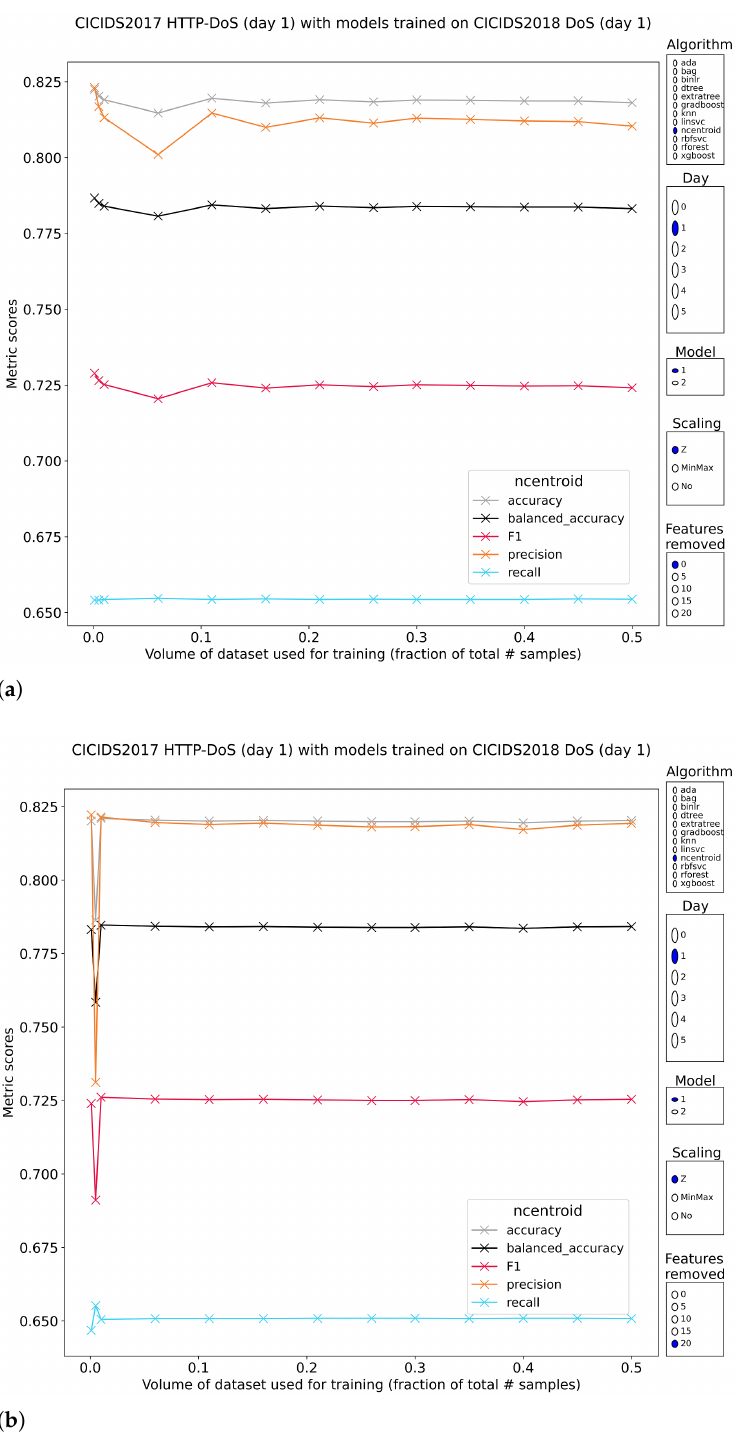
Figure 6. Generalized performance of the nearest centroids models when evaluating L7-DoS attacks between datasets and their resistance to the removal of highly discriminative features prior to